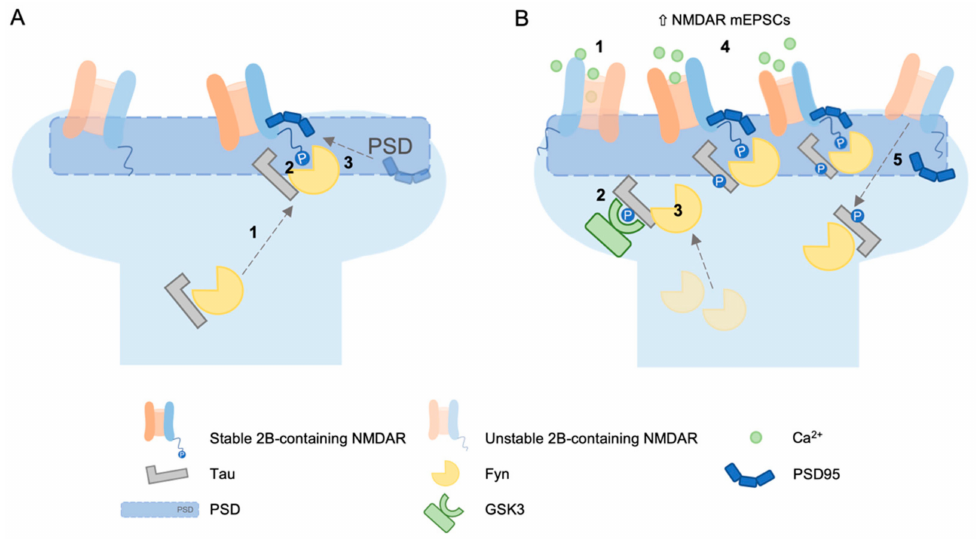
Figure 1. ( A ) Fyn localises to the postsynapse in a tau-dependent manner (1) where it associates with the postsynaptic density and phosphorylates GluN2B in the carboxy terminus domain (2). Since this phosphorylation facilitates the interaction of NMDARs with the scaffolding protein PSD-95 (3), Tau–Fyn interaction in spine increases the stability of NMDAR within the PSD [11]. ( B ) According to the Mondrag ó n-Rodr í guez model [12], the activation of NMDAR (1) leads to phosphorylation of tau by GSK3 (2). This phosphorylation strengthens the interaction between tau and Fyn (3), thus supporting a transient increase in NMDA receptor activation (4), but weakens the interaction between PSD95 and tau. As a result, Fyn finally leaves the PSD95-NMDA receptor complex